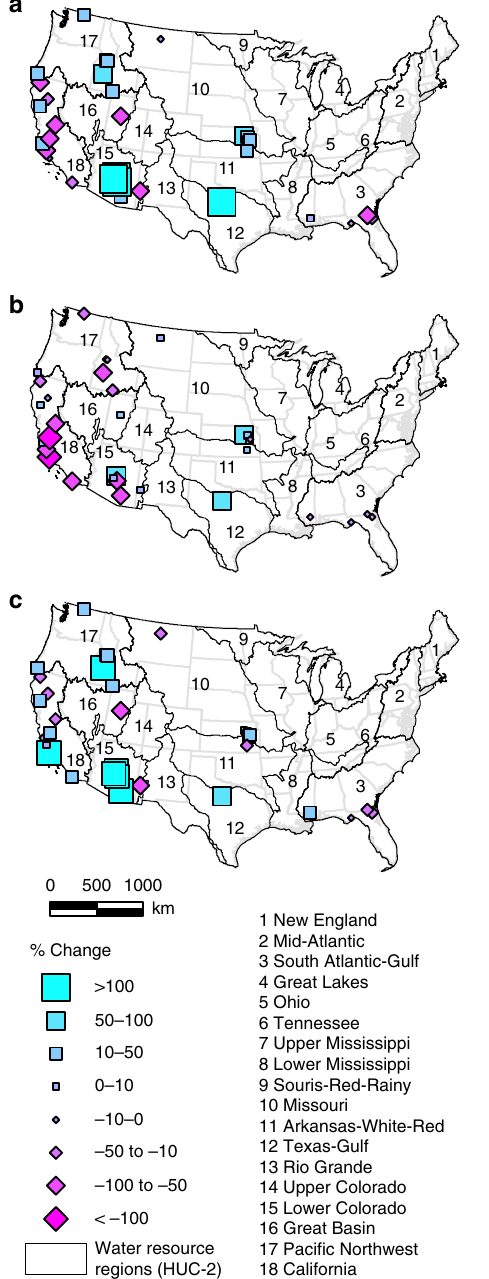
Fig. 1 Change of annual river fl ow in US watersheds burned at any time between 1985 and 2008. Percentage observed change in 5-year mean annual river fl ow ( a ), percentage change attributed to climate ( b ), and percentage attributed to wildland fi re ( c ). Attribution was performed using climate elasticity models fi tted for each watershed individually ( n = 32 burned watersheds with BAR ≥